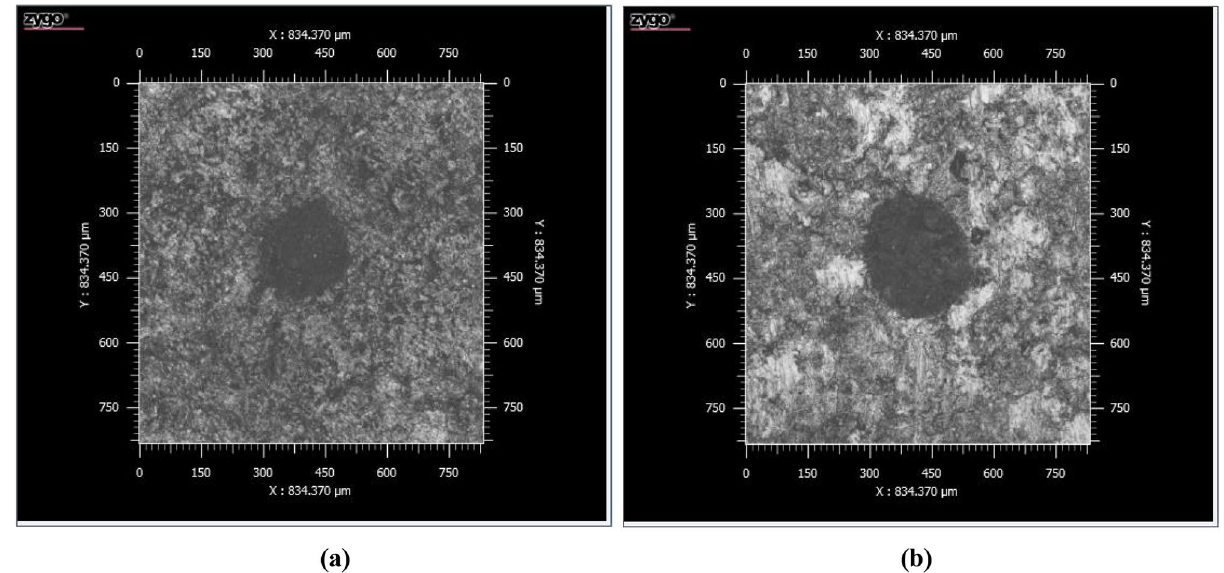
Figure 9. 2D surface profilometry images of single shots ablation using fs-Solstice system in ( a ) and ns-Chem system in ( b ) clarifying the reduced thermal effects of